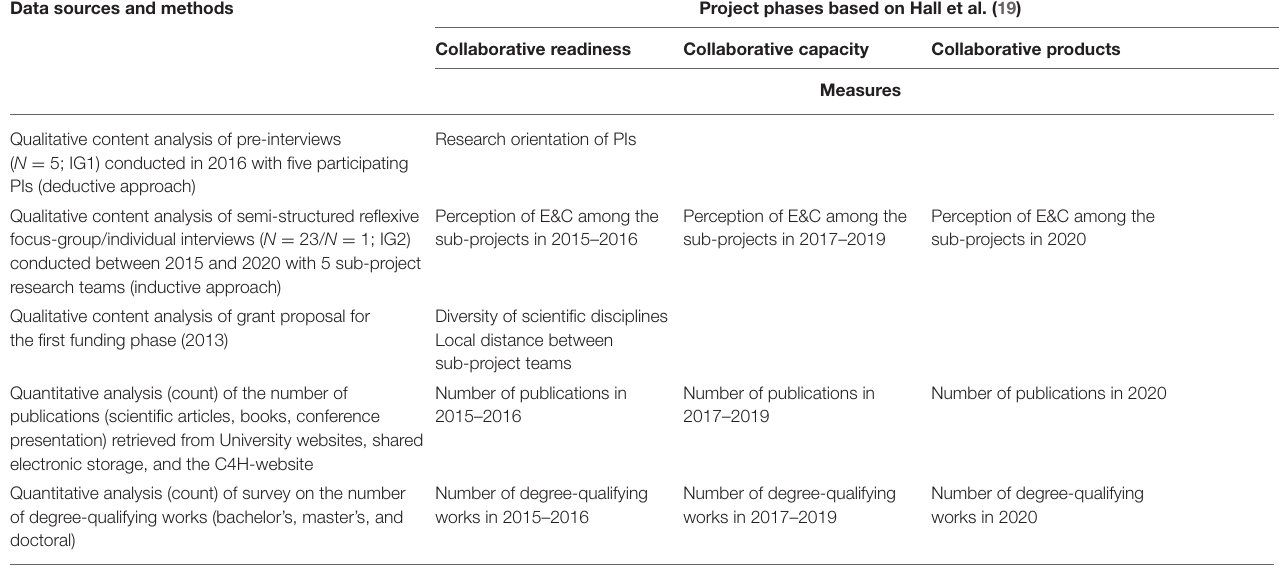
TABLE 1 | Mixed-methods design applied in this